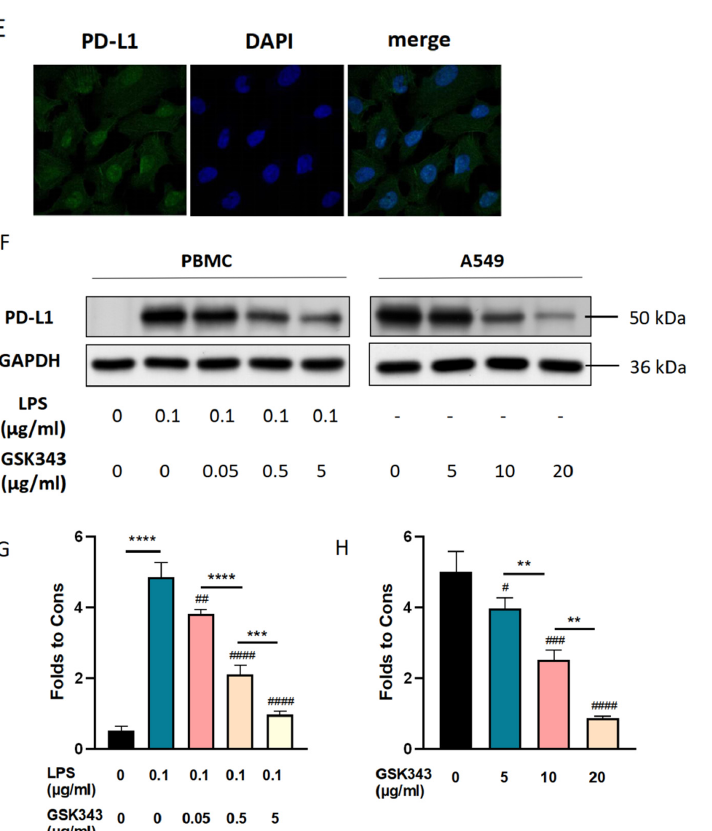
Figure 4. GSK343 decreased the protein level of PD-L1 in LPS-induced PBMCs and A549. ( A ) The